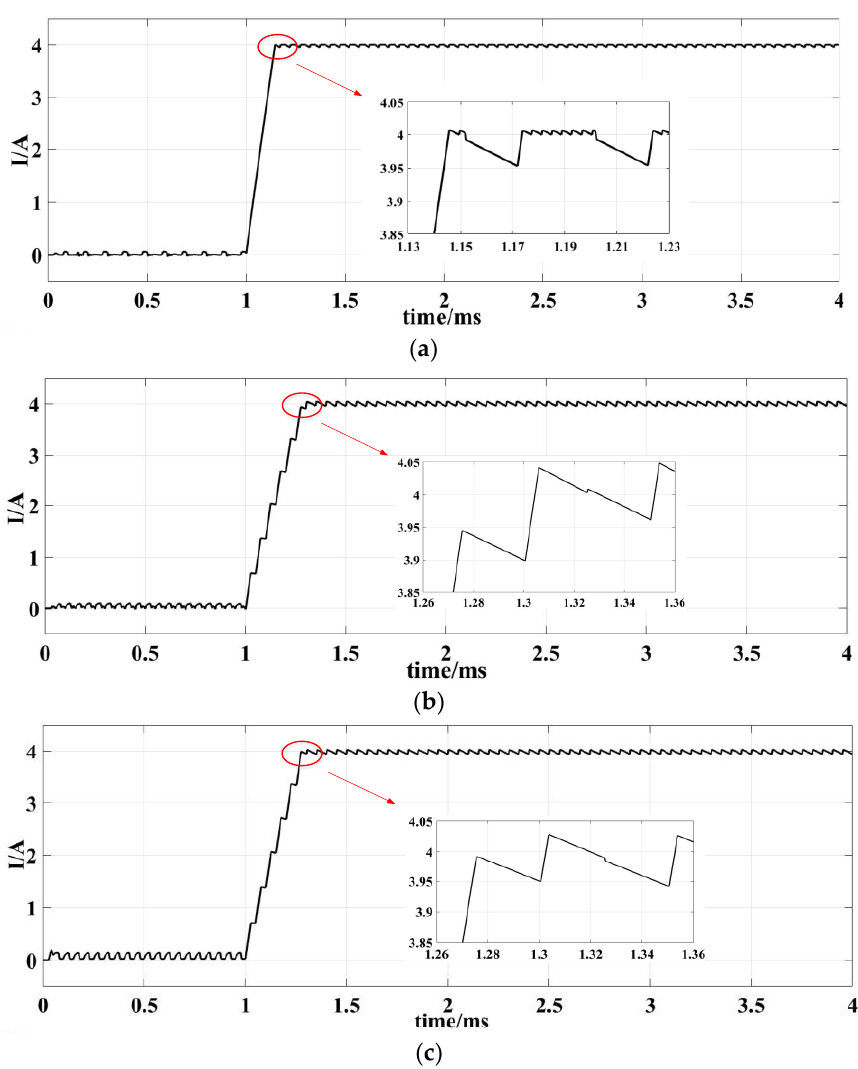
Figure 16. Current rise curves of SPAs with ( a ) half-bridge topology, ( b ) three-phase-half-bridge topology, and ( c ) neutralized-sharing-bridge topology. topology, and ( c ) neutralized-sharing-bridge